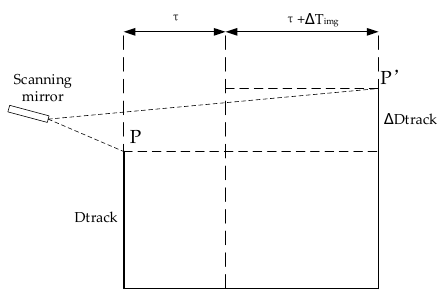
Figure 4. The diagram of deviation along the track caused by the imaging time error.